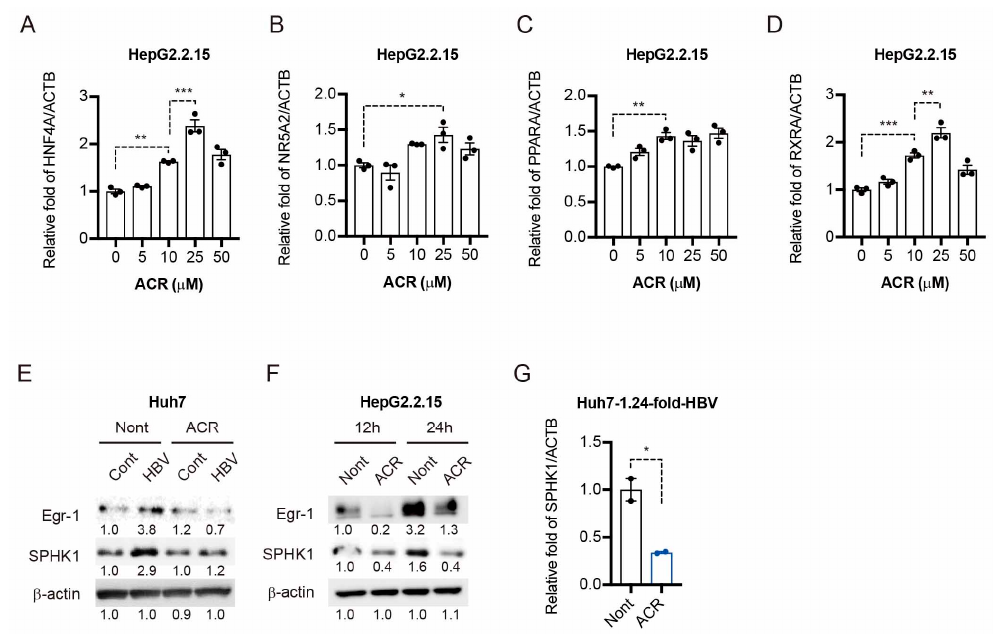
Figure 3. Peretinoin inhibits Egr-1-SPHK1 axis in HBV-replicating cells. ( A – D ) HepG2.2.15 cells were treated with 0, 5, 10, 25, or 50 μ M of peretinoin for 5 days. qRT-PCR analysis of HNF4A ( A ), NR5A2 ( B ), PPAR α ( C ), and RXR α ( D ) mRNA in peretinoin-treated HepG2.2.15 cells. Results were normalized to those of the β -actin mRNA level. ( E , G ) A plasmid encoding 1.24-fold-HBV or a control empty vector was transfected into Huh7 cells and 24 h after transfection, 30 μ M of peretinoin was added for 3 days. Egr-1, SPHK1, and β -actin protein levels were detected by Western blotting analysis in Huh7 cells ( E ) and qRT-PCR analysis of SPHK1 mRNA in peretinoin-treated HepG2.2.15 cells ( G ). ( F ) HepG2.2.15 cells were treated with peretinoin at a concentration of 0 or 30 µ M. 12 h and 24 h after inoculation, Egr-1, SPHK1, and β -actin protein levels were determined by Western blotting analysis ( F ). The data are represented as means ± SEM. * p < 0.05, ** p < 0.01, *** p < 0.001.